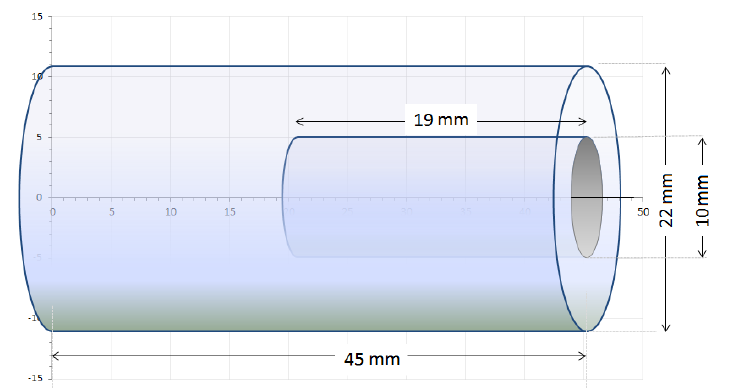
Fig. 1: Schematic of hollow cathode electrode used in the dc discharge system.